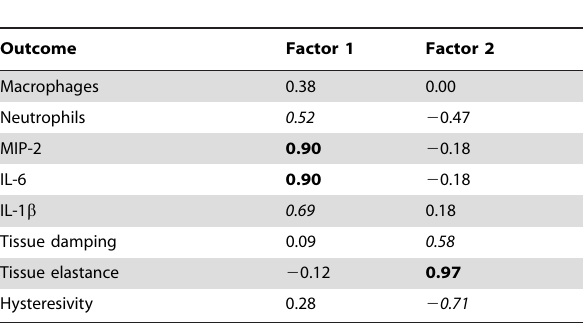
Table 4. Results of the principal components factor analysis for the eight outcomes included in model, with loadings for each outcome.